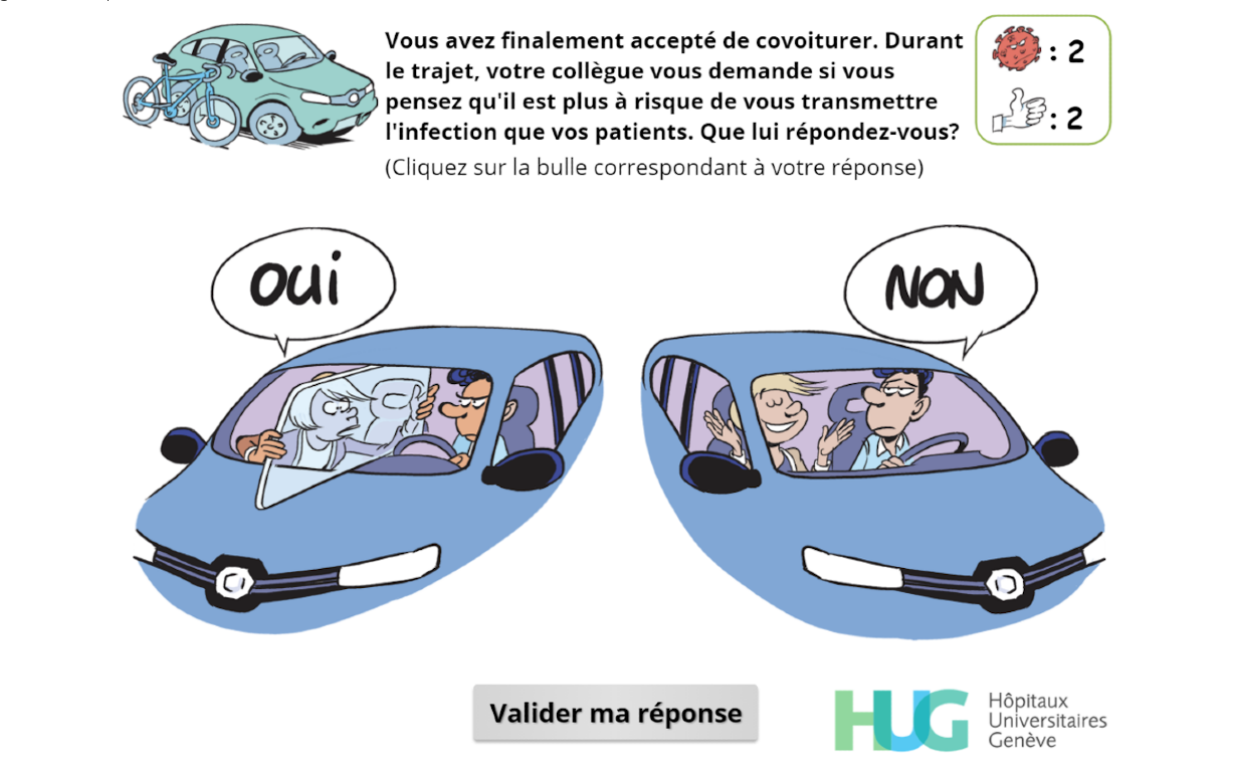
Figure 2. Simple-choice interaction.